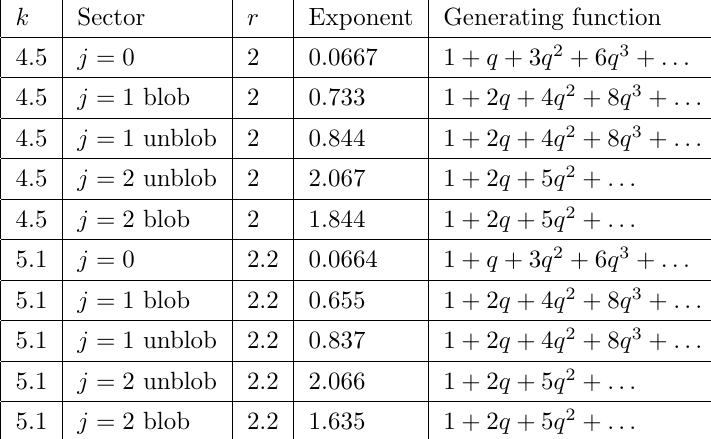
Table 1 . Some examples of the generating functions and critical exponents observed numerically on the lattice for two di(cid:11)erent values of k and r , in both the blobbed and the unblobbed sectors. The generating functions are written to the order to which they can be clearly observed on the lattice by diagonalising the transfer matrix for the alternating loop model. Up to this order they agree with the generating functions de(cid:12)ned in eqs.